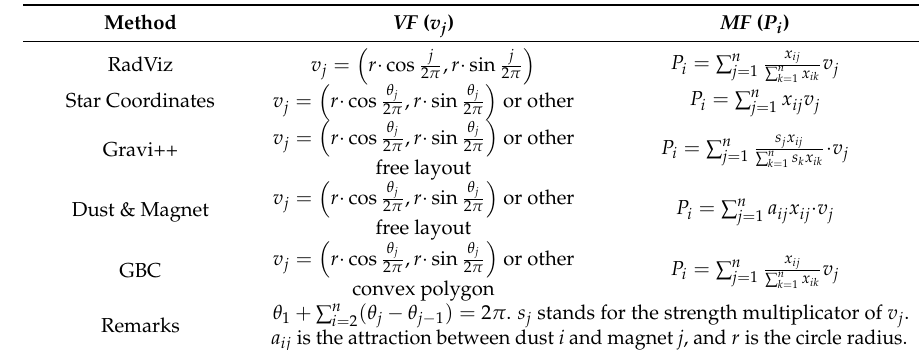
Table 1. The various contextual layout methods expressed in a common notation ( VF : vertices’ function, MF : mapping function).